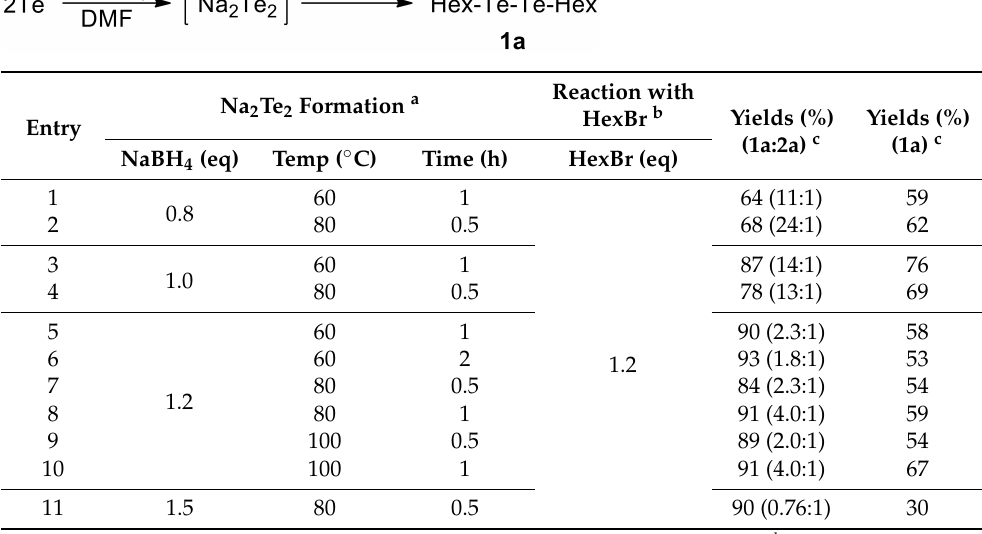
Table 1. Optimization of reaction condition using NaBH 4